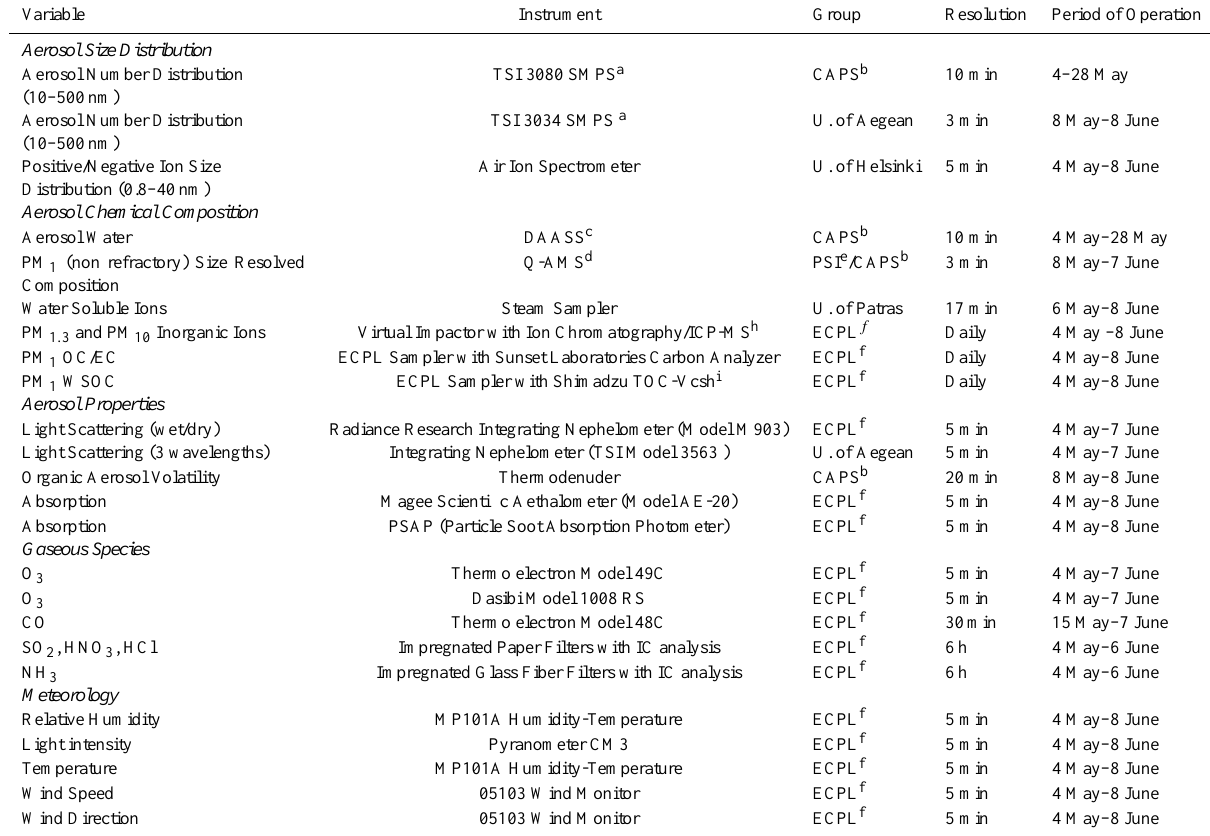
Table 1. Summary of FAME-08 measurements Variable Aerosol Size Distribution Aerosol Number